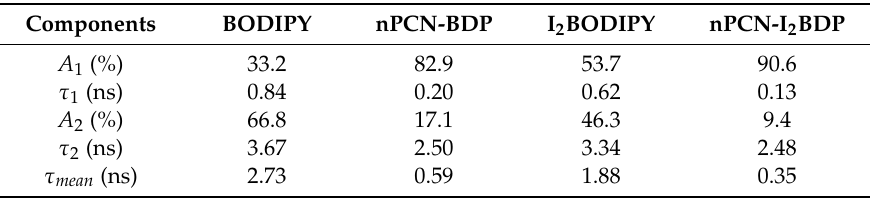
Table 1. Fitting parameters for fluorescence decay curves of donor emission of BODIPY, nPCN-BDP, I 2 BODIPY, and nPCN-I 2 BDP shown in Figure 6b,d.